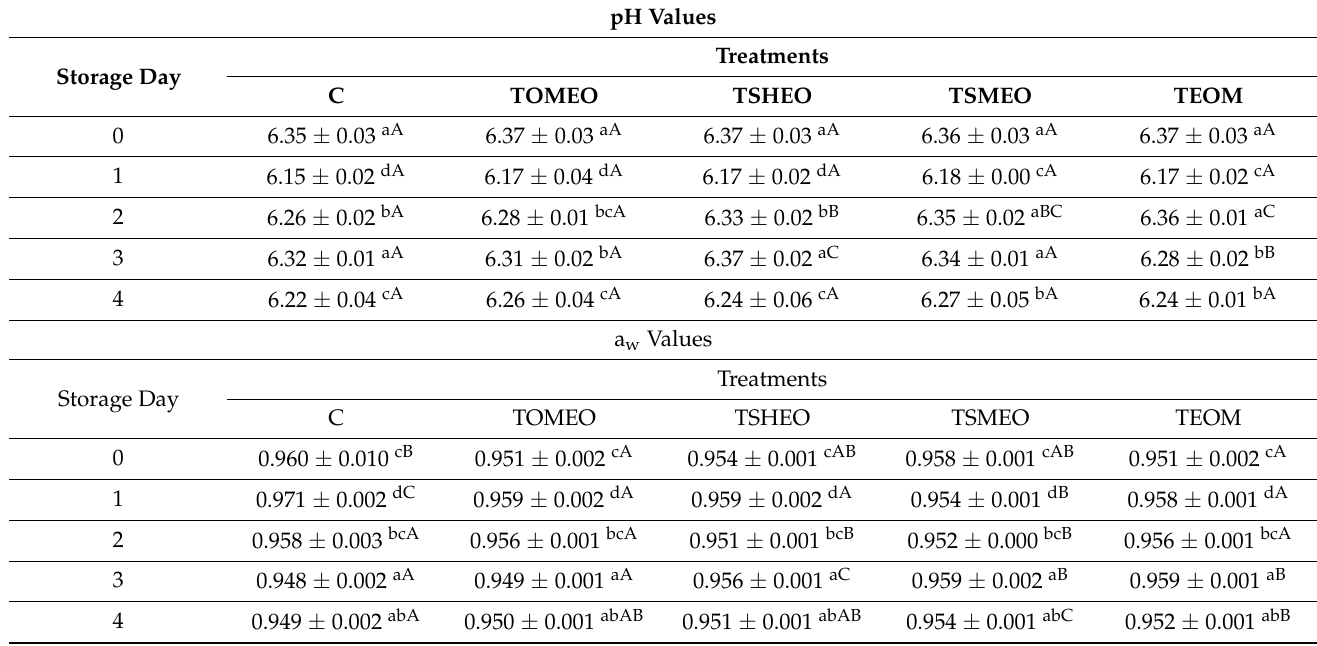
Table 3. pH and water activity (a w ) values of fresh turkey